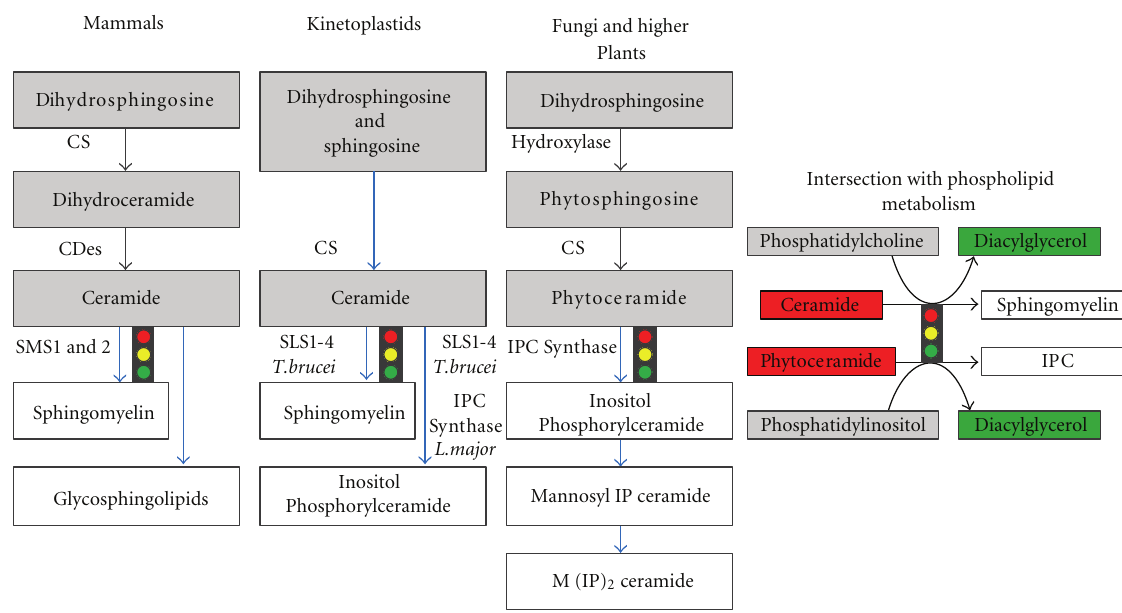
Figure 3: Divergence in the postceramide biosynthetic steps highlighting the conserved intersection with phospholipid metabolism as a regulator of the balance between promitogenic diacylglycerol (DAG) and proapoptotic ceramide. The key regulatory synthetic steps are in- dicated by the “tra ffi c light” symbols. CS: Ceramide Synthase; CDes: Ceramide Desaturase; SMS: Sphingomyelin Synthase; SL: Sphingolipid; IPC: Inositol Phosphorylceramide; PC: